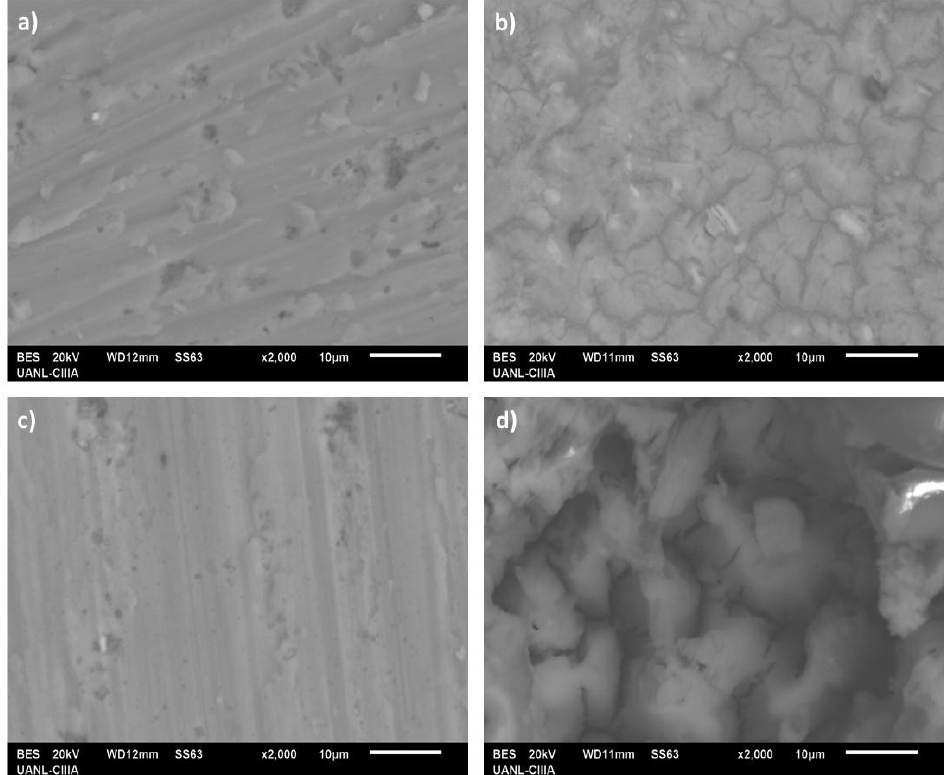
Figure 4. SEM surface morphology micrographs of the samples anodized in sulfuric acid solution and citric–sulfuric acid solution. ( a ) SA (sulfuric acid) / 1 A · cm − 2 , ( b ) SA (sulfuric acid) / 7.2 A · cm − 2 , ( c ) CA (citric acid) / 1 A · cm − 2 and ( d ) CA (citric acid) / 7.2 A · cm − 2 .